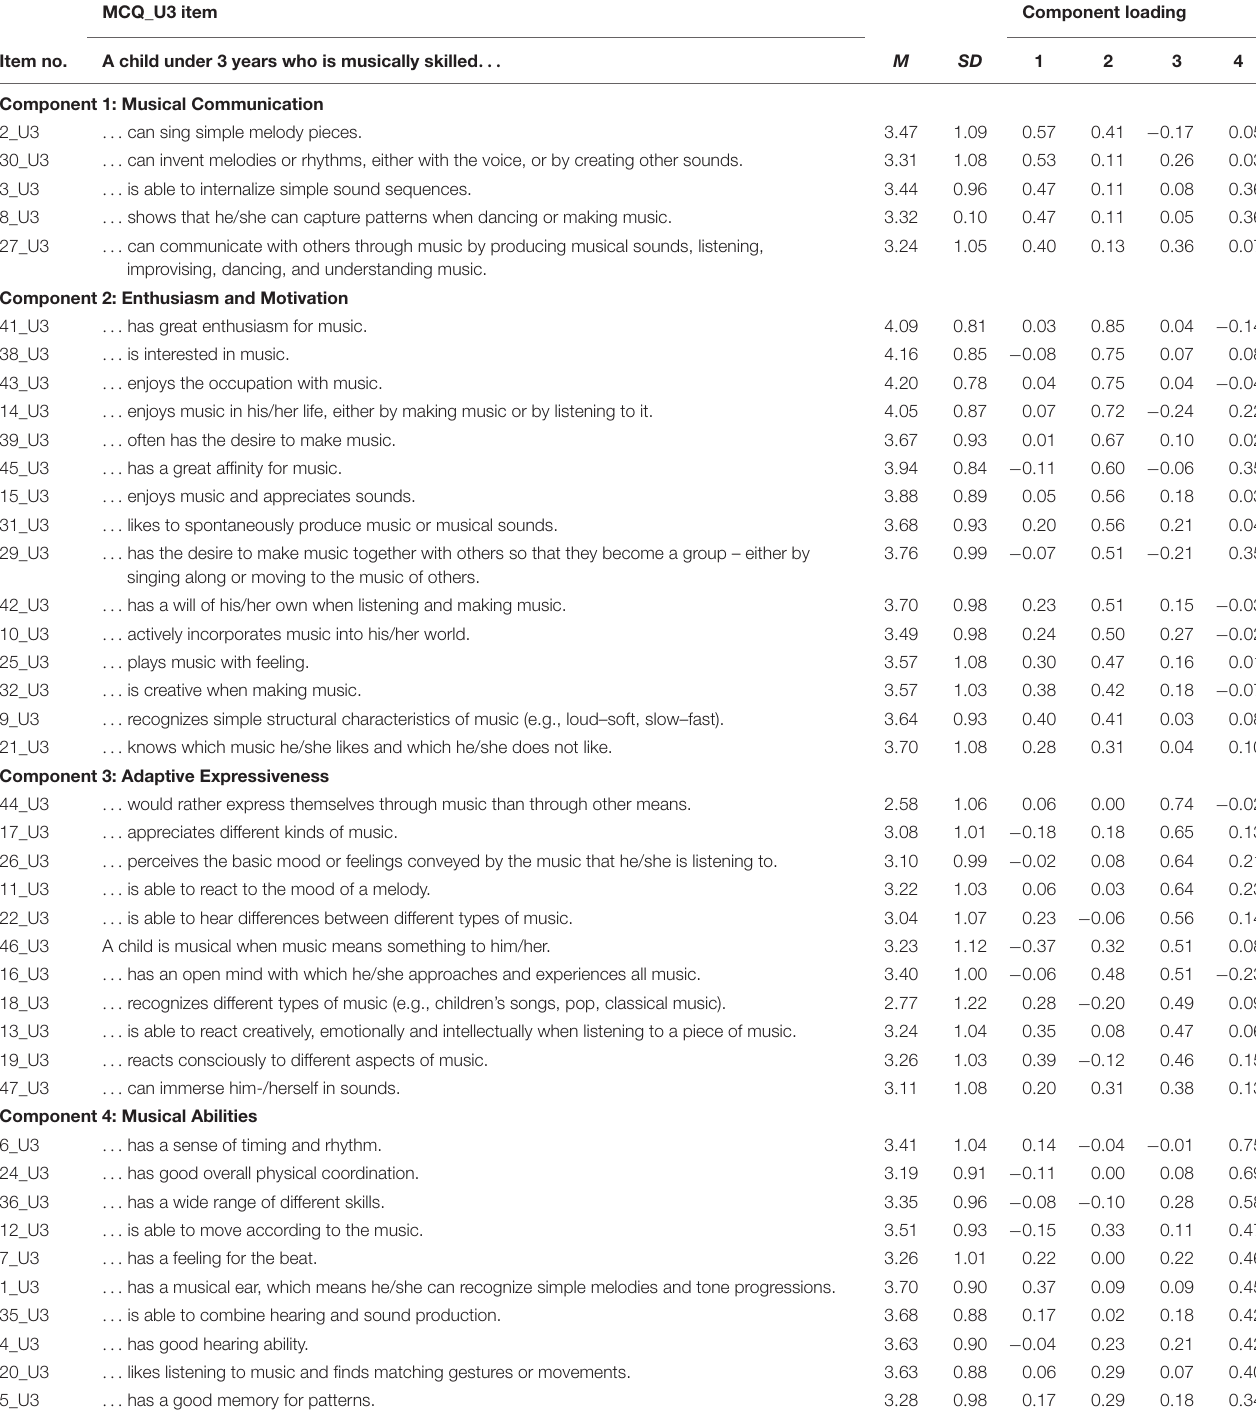
TABLE 3 | Items of the Musical Infant/Toddler Questionnaire (MCQ_U3), grouped by components. MCQ_U3 item Component loading Item